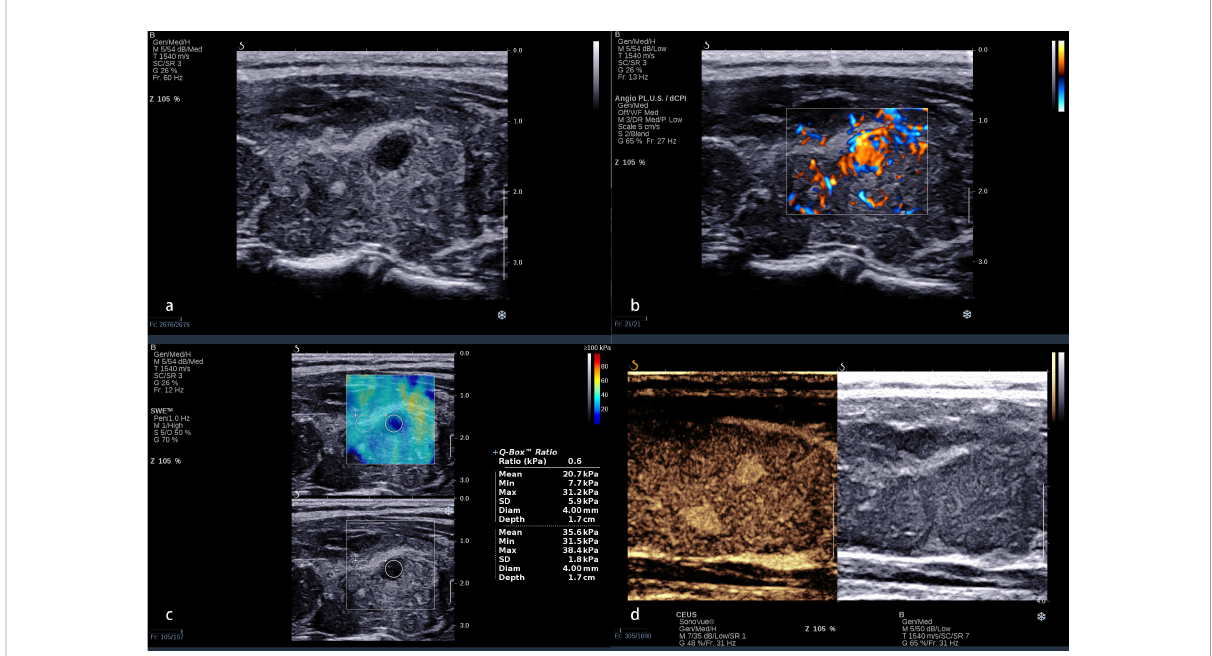
FIGURE 2 A 32-year-old woman with a nodule in the left lobe of the thyroid. (A) Conventional ultrasound revealed a 5 × 6-mm solid hypo-echoic nodule with a smooth margin, shape that was taller-than-wide, and without obvious calci fi cation; this was categorized ACR TI-RADS 5. (B) The